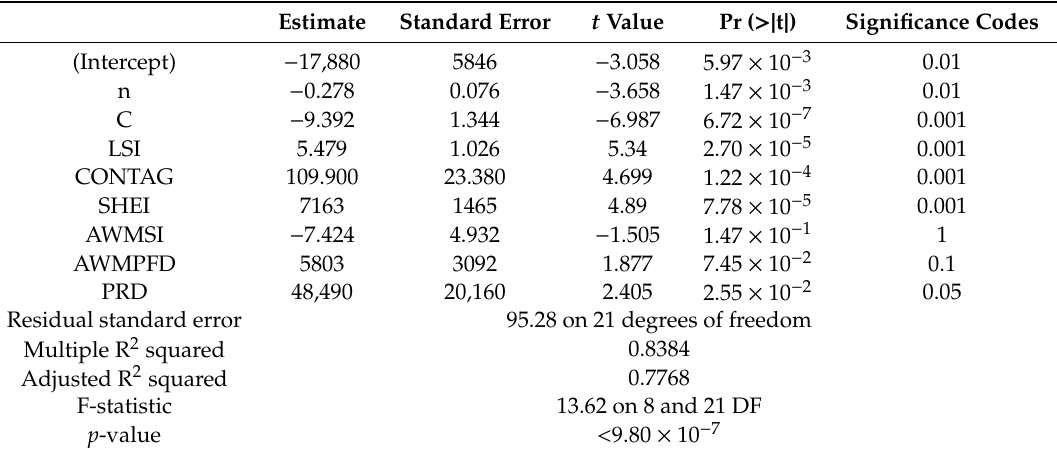
Table 4. Multi-level regression coe ffi cients of sample size N S